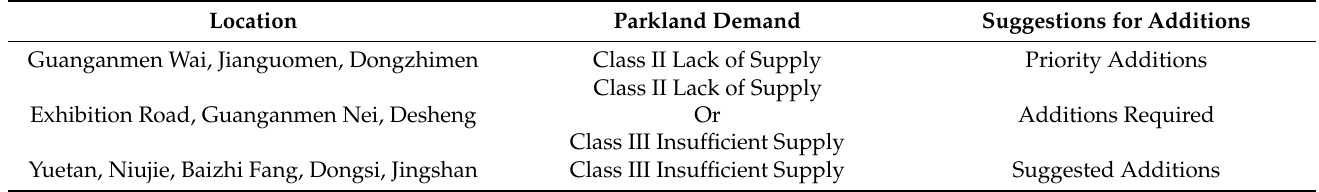
Table 10. Table of proposed additional parkland